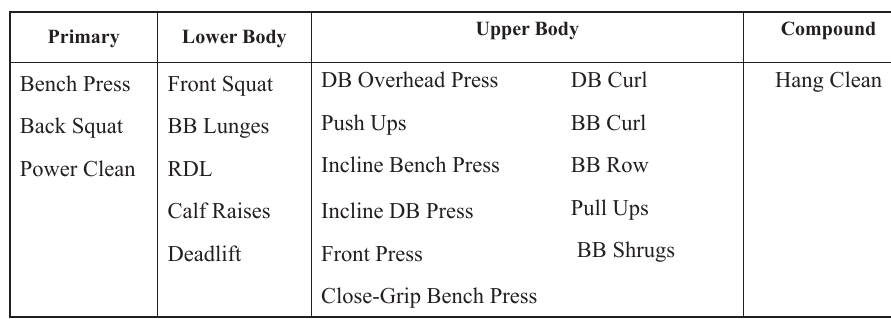
Table 1. Exercises used throughout the 6-week training period